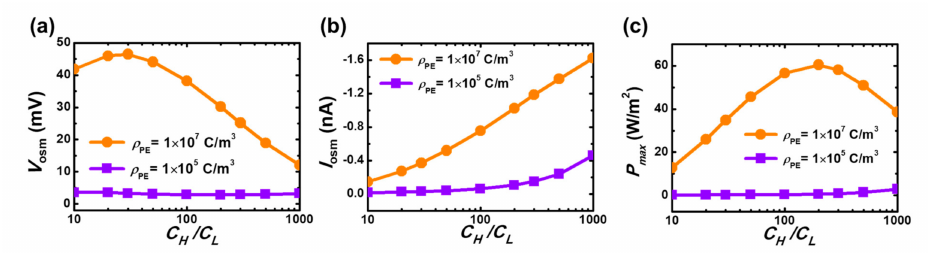
Figure 6. ( a ) Simulated osmotic voltage, ( b ) osmotic current, and ( c ) maximum osmotic power density as a function of the concentration gradient for the two levels of space charge densities. The lower salt concentration is fixed at 1